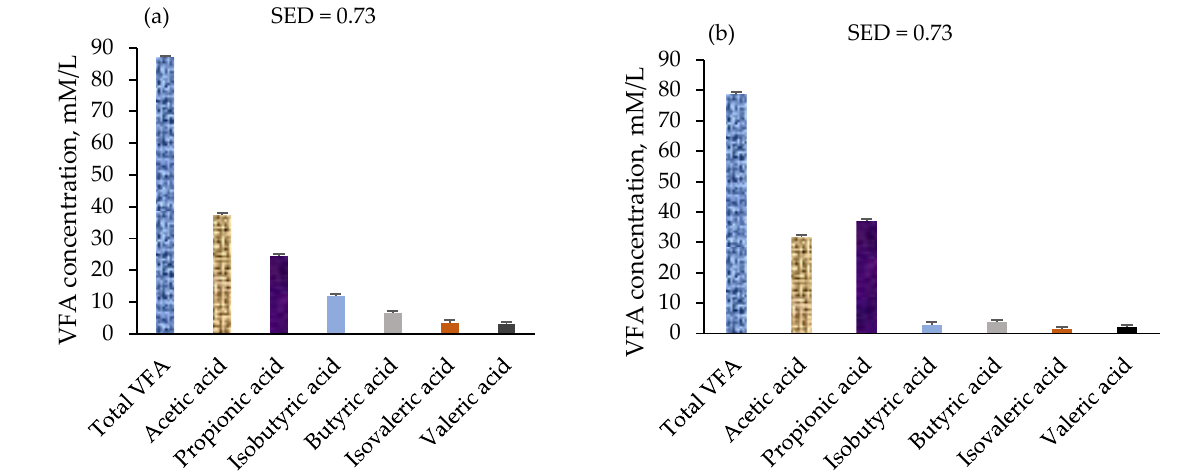
Figure 3. The amount of volatile fatty acids (VFAs) produced from ( a ) wheat grain and ( b ) lucerne hay after 24 h fermentation using rumen fluid, either fresh or treated with DMSO and kept at D − 20 °C for 180 days. Data are least-square means of di ff erent VFAs in the substrate.